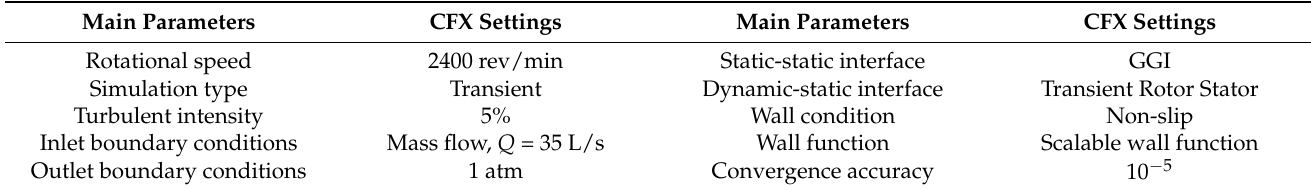
Table 1. Calculation parameter settings.